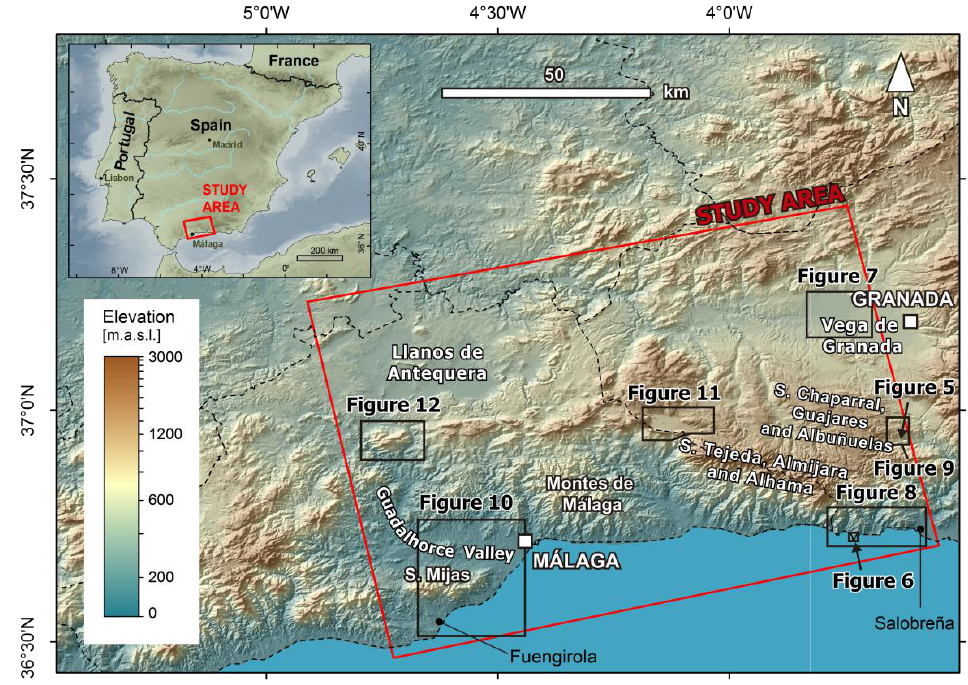
Figure 1. Location of the study area, the main geographical features cited in the text and the areas referenced in the Section 4. The limits of the provinces are defined by dotted lines.